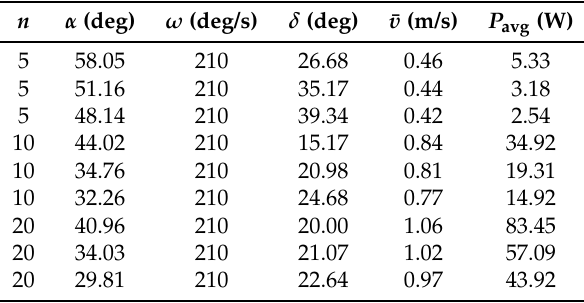
Table 5. Multi-objective optimization results for the lateral undulation motion pattern for the USR with different numbers of links, without considering the negative work effect.